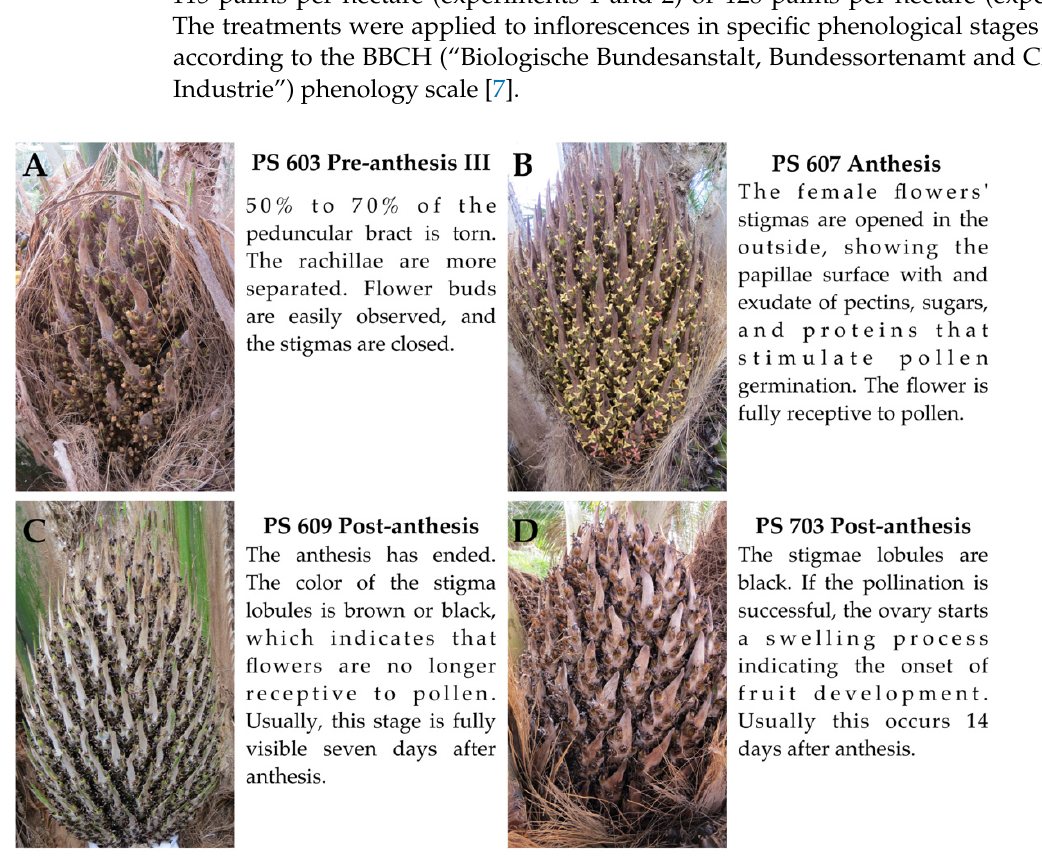
Figure 1. Phenological stages (PS) used in the different experiments. ( A ) PS 603 (Pre-anthesis III). ( B ) PS 607 (anthesis). ( C ) PS 609 (post-anthesis, seven days after anthesis). ( D ) PS 703 (post-anthesis 14 days after anthesis). The phenological stages were defined according to the BBCH phenological scale developed by [7] .